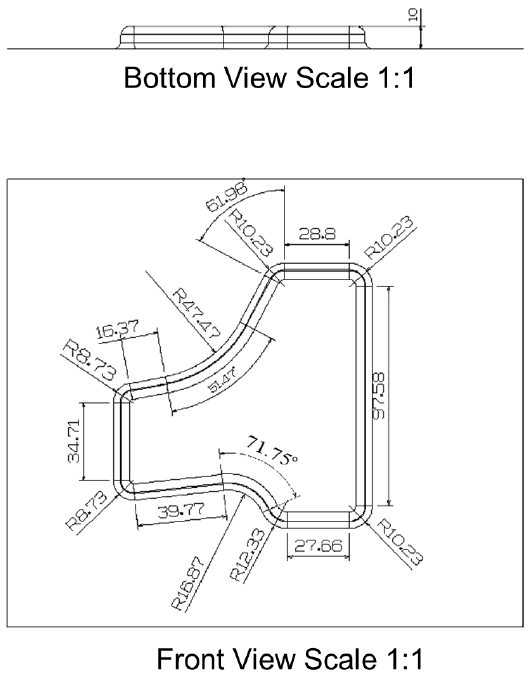
Figure 1. T-type part designed for hot stamping test (unit: mm).